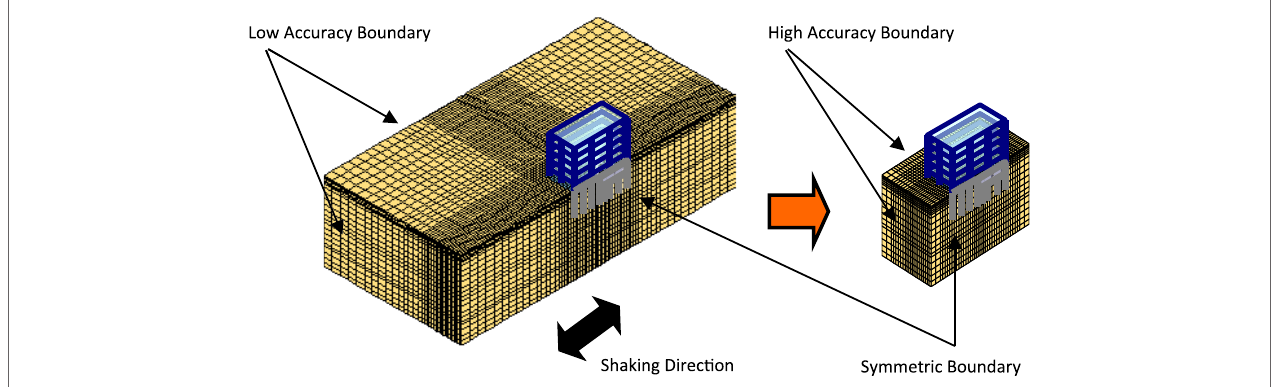
FigUre 1 | reduction of analysis region of inner field by high-accuracy boundary